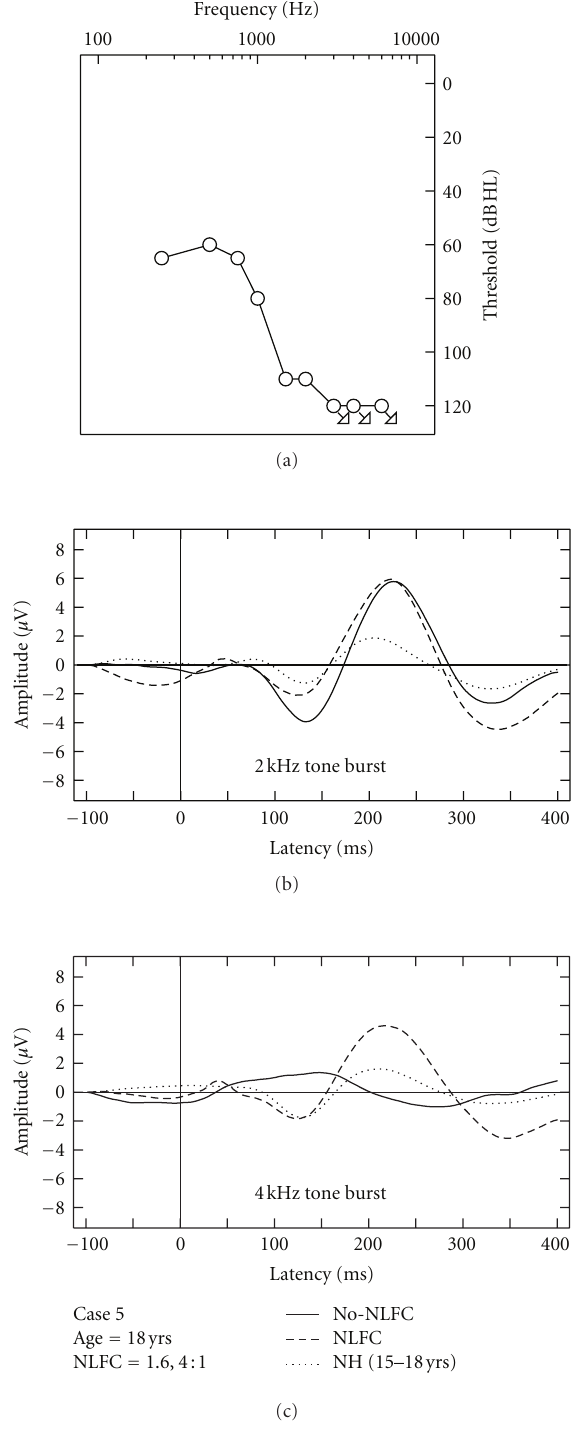
Figure 7: Case-specific grand mean CAEPs displayed across stimulus types and hearing aid conditions: no-NLFC (solid line), NLFC active (dashed line), and for each participant’s age-matched NH group (dotted line). Participant age and prescribed NLFC settings (cut-o ff frequency, compression ratio) are indicated in the legend. The top left corner pane displays test ear hearing thresholds, suspected cochlear dead regions (DR), and responses beyond the audiometric test